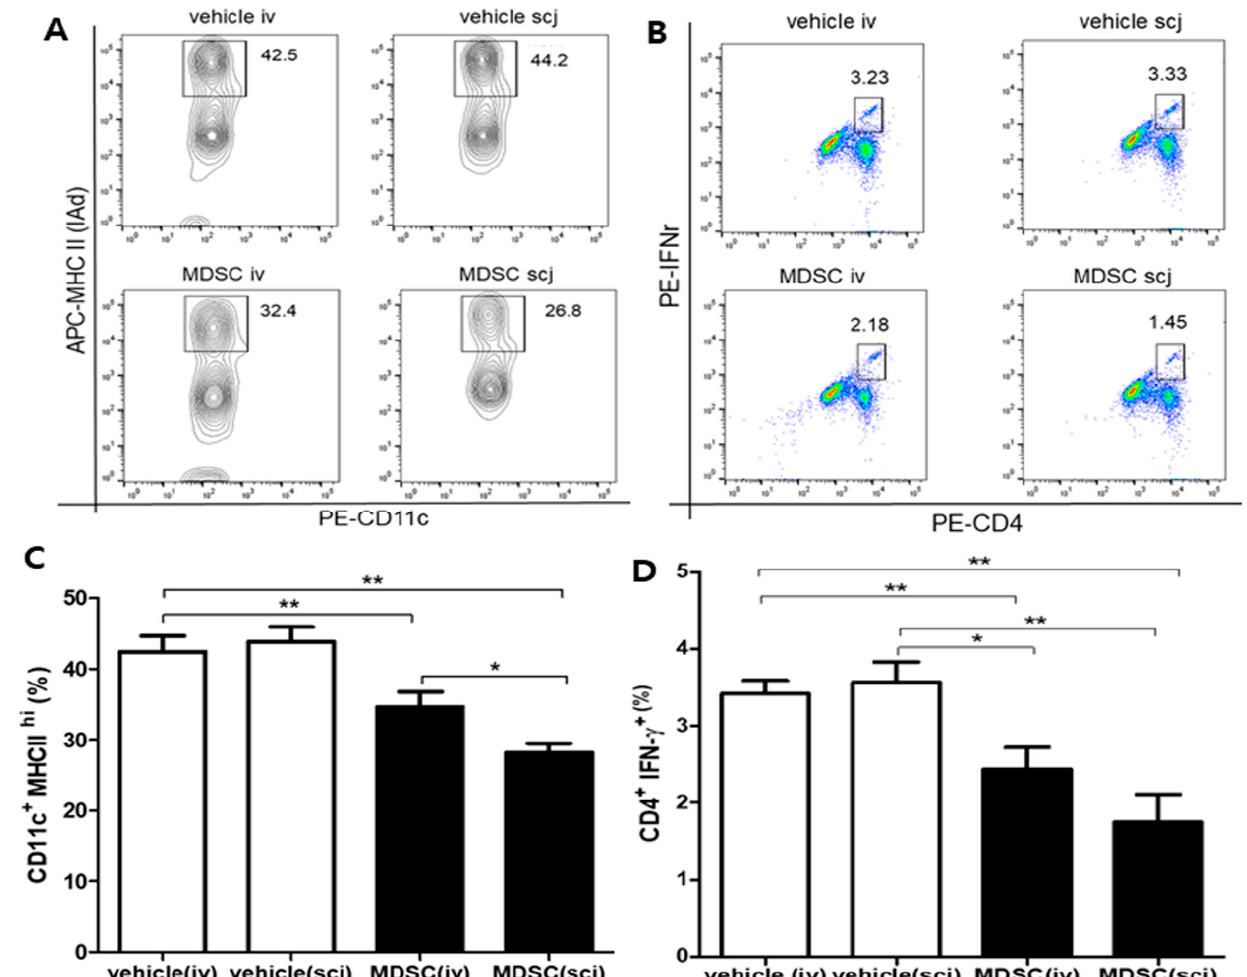
Figure 2. Populations of major histocompatibility complex (MHC) II hi CD11c+ cells and differ- entiation of interferon (IFN)- γ -expressing effector T cells in draining lymph nodes after corneal transplantation. Populations of MHC II hi CD11c+ dendritic cells (DC) and differentiation of inter- feron (IFN)- γ -expressing effector T cells in draining lymph nodes (LNs). ( A ) Representative flow cytometry plot showing MHC II hi CD11c+ cells after CD11c+ gating. ( B ) Representative flow cytome- try plot presenting the differentiation of IFN γ + CD4+ cells. ( C ) Quantitative analysis of MHC II hi CD11c+ cell populations ( n = 3). Comparison between MDSCs (MDSC iv, MDSC scj) and vehicle (PBSiv, PBSscj) showed that the MDSCs groups presented a decreased maturation of MHC II hi CD11c+ cells, whereas the vehicle groups did not. The immunomodulating effect of MDSCs was significantly better in the local (scj) injection group than in the systemic (iv) injection group. ( D ) Quantitative analysis graph of IFN γ + CD4+ cell differentiation ( n = 3). MDSCs groups (MDSC iv, MDSC scj) led to inhibit differentiation of IFN γ + CD4+ cells when compared with vehicle groups (PBSiv, PBSscj). Representative flow cytometric data from three independent trials with pooled cells from three mice per group. * p < 0.05, ** p <